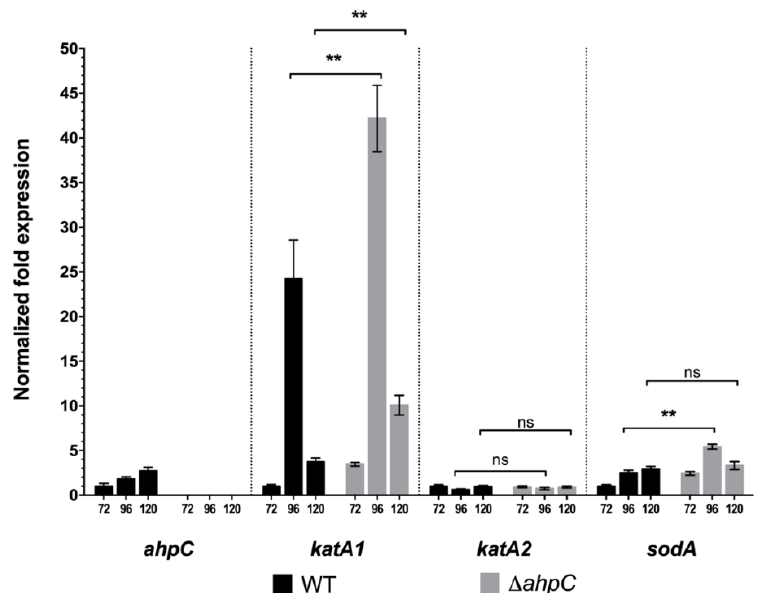
Figure 2. RT-qPCR gene expression analysis of antioxidant encoding genes in S. tsukubaensis wild type (black bars) and ∆ a hpC strain (grey bars) grown in MGm-2.5 medium. The mean normalized (black bars) and ∆a hpC strain (grey bars) grown in MGm-2.5 medium. The mean normalized fold expression (±standard errors) of genes a hpC ( STSU_11585 ), katA1 ( STSU_10876 ), katA2 ( STSU_11535 ) and sodA ( STSU_24238 ) at 72 h, 96 h and 120 h of growth was calculated relative to the transcription of the reference genes rpsP ( STSU_08694 ) and hrdB (M value 0.4432) and the reaction of internal